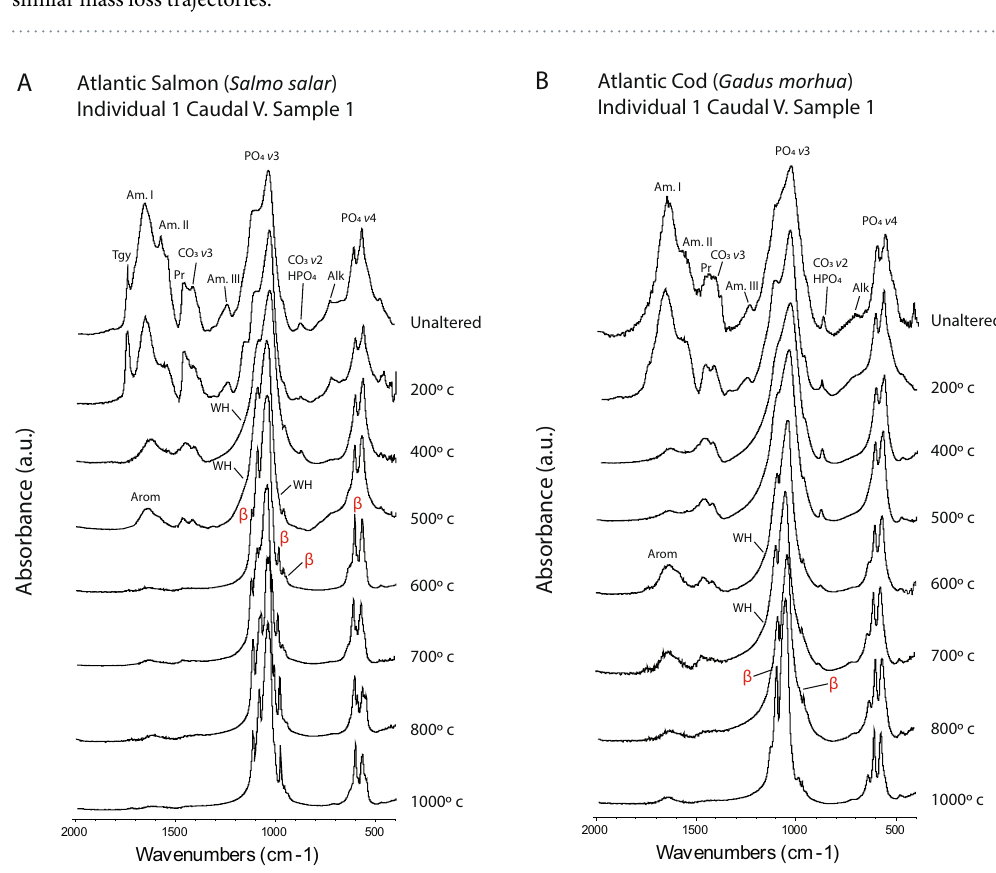
Figure 3. FTIR Spectra of Salmon and Codfish Bones Heat Treated through a Ramping Temperature Sequence between 200 °C and 1,000 °C. ( A ) Atlantic Salmon; note the loss of the HPO 4 /CO 3 peak and appearance of strong β MgTCP peaks at 600 °C; ( B ) Atlantic Cod; the loss of the HPO 4 / CO 3 peak and appearance of weak β MgTCP peaks occurs at 800 °C; abbreviations: Tgy = triglyceride ester; Am = amide; Alk = alkene; Pr = proline; CO 3 = carbonate; PO 4 = phosphate; HPO 4 = hydrogen phosphate; Arom = aromatic char compounds; WH = whitlockite; β = beta magnesium tricalcium